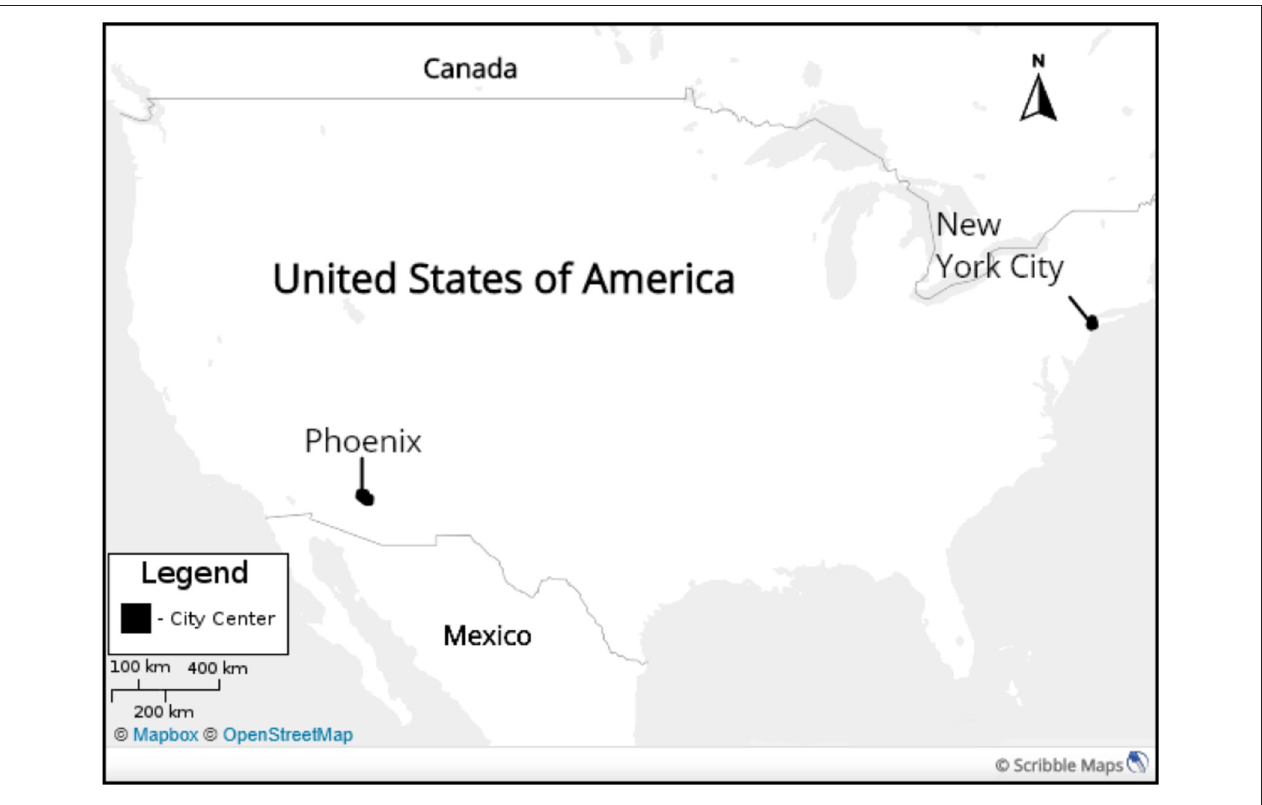
Number H16-02583-A002). Our data were collected as part of a larger research project investigating urban green equity in